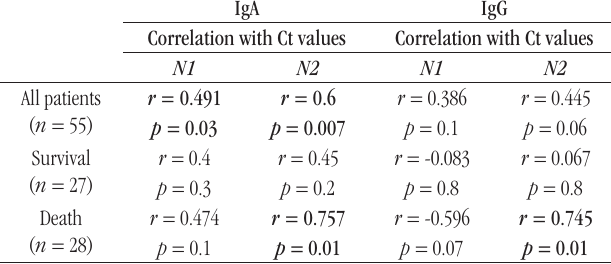
TABLE 2 – Correlations between IgA and IgG levels and Ct for N1 and N2 Sars-CoV-2 gene targets values at week 1 according to the